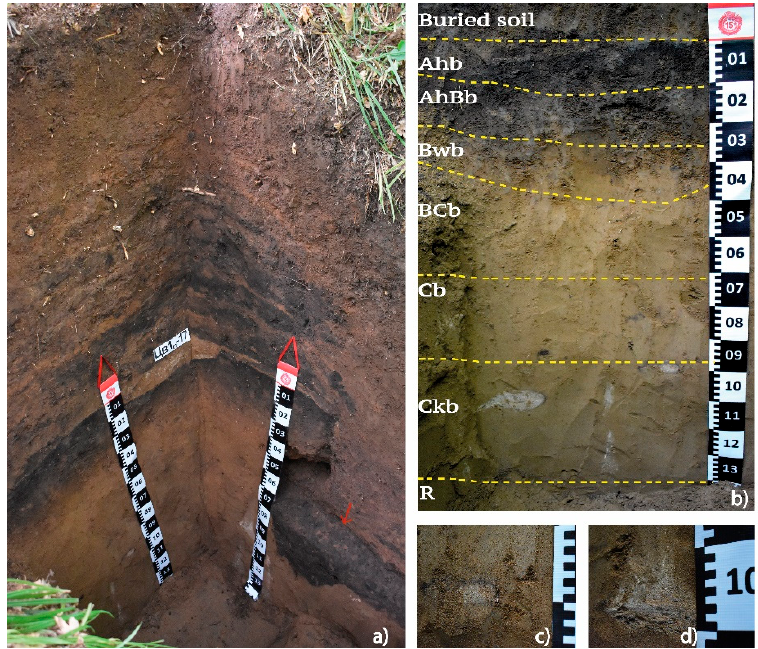
Figure 4. The general view of the pit (295 cm deep) made in the kurgan during the field research ( a ) and the profile of the buried soil ( b – d ). ( a ) the stratified mound material and the buried soil ( Folic Eutric Cambisol Protocalcic ) exposed in the western ( left ) and northern ( right ) walls. Note 2–5 cm thick pale brown layer separating the buried soil from the mound and the grave filled with black earth on the northern wall (indicated by red arrow); ( b ) general view of the buried soil profile; ( c , d ) altered calcareous coarse sandstone fragments in Ckb horizon.